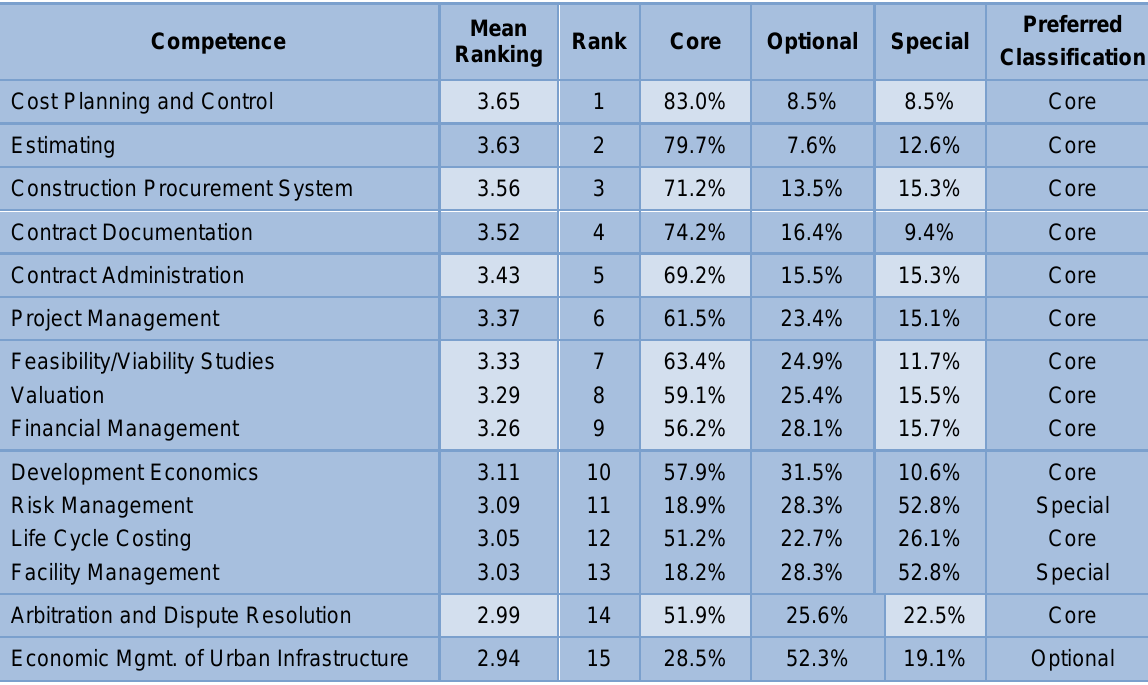
Table 4 Classification of Competencies Expected of Quantity